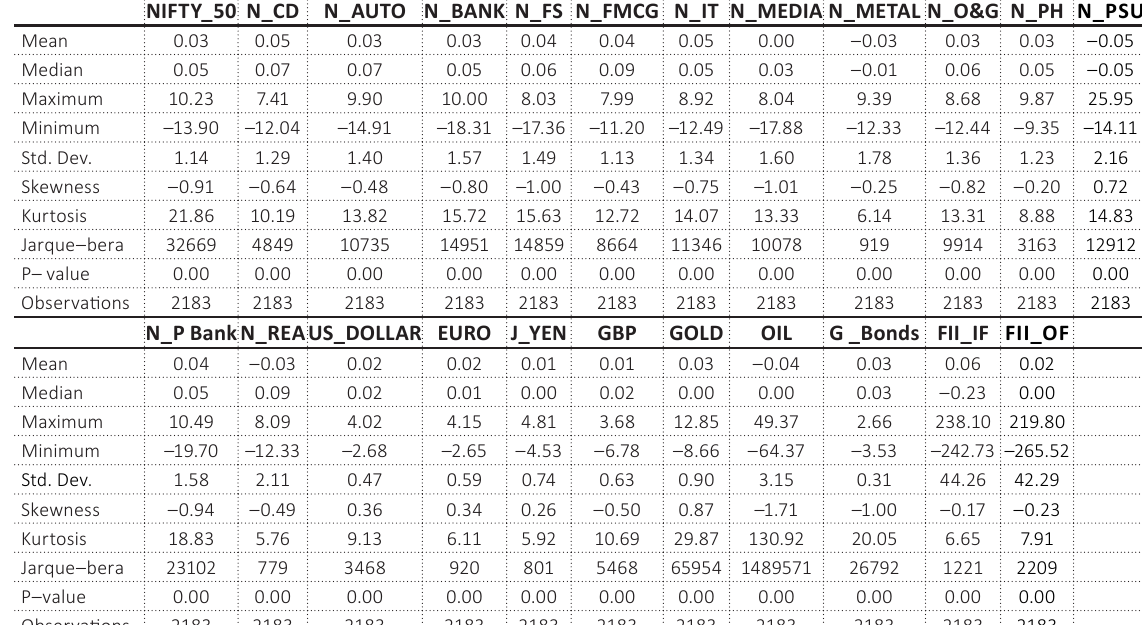
Table 1. Results of descriptive